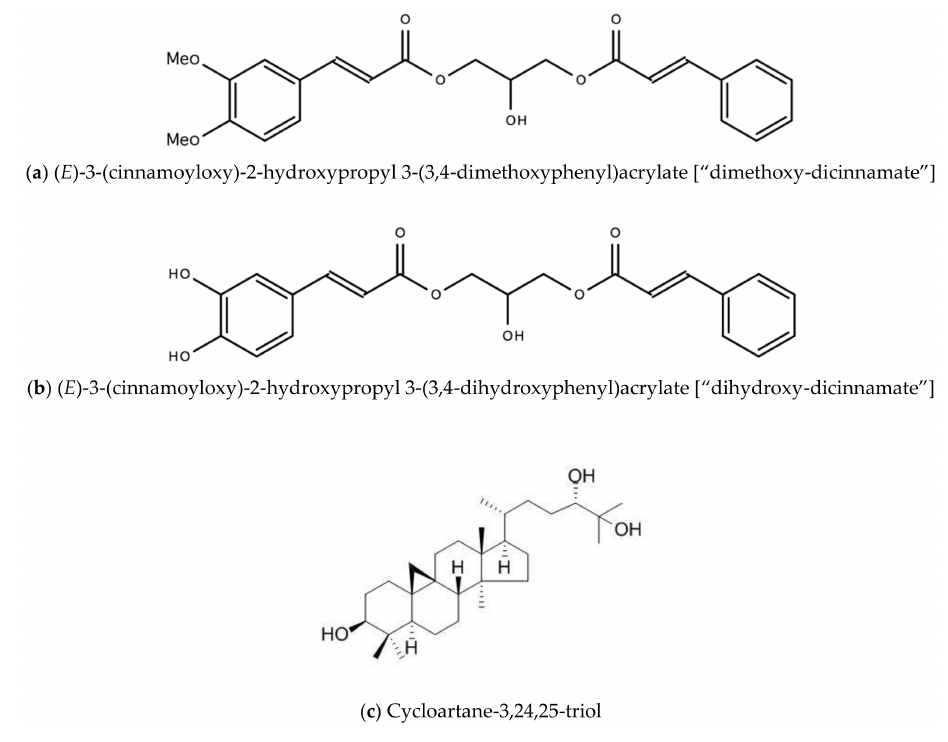
Figure 2. Chemical structures of some bioactive molecules found in Tillandsia recurvata L.